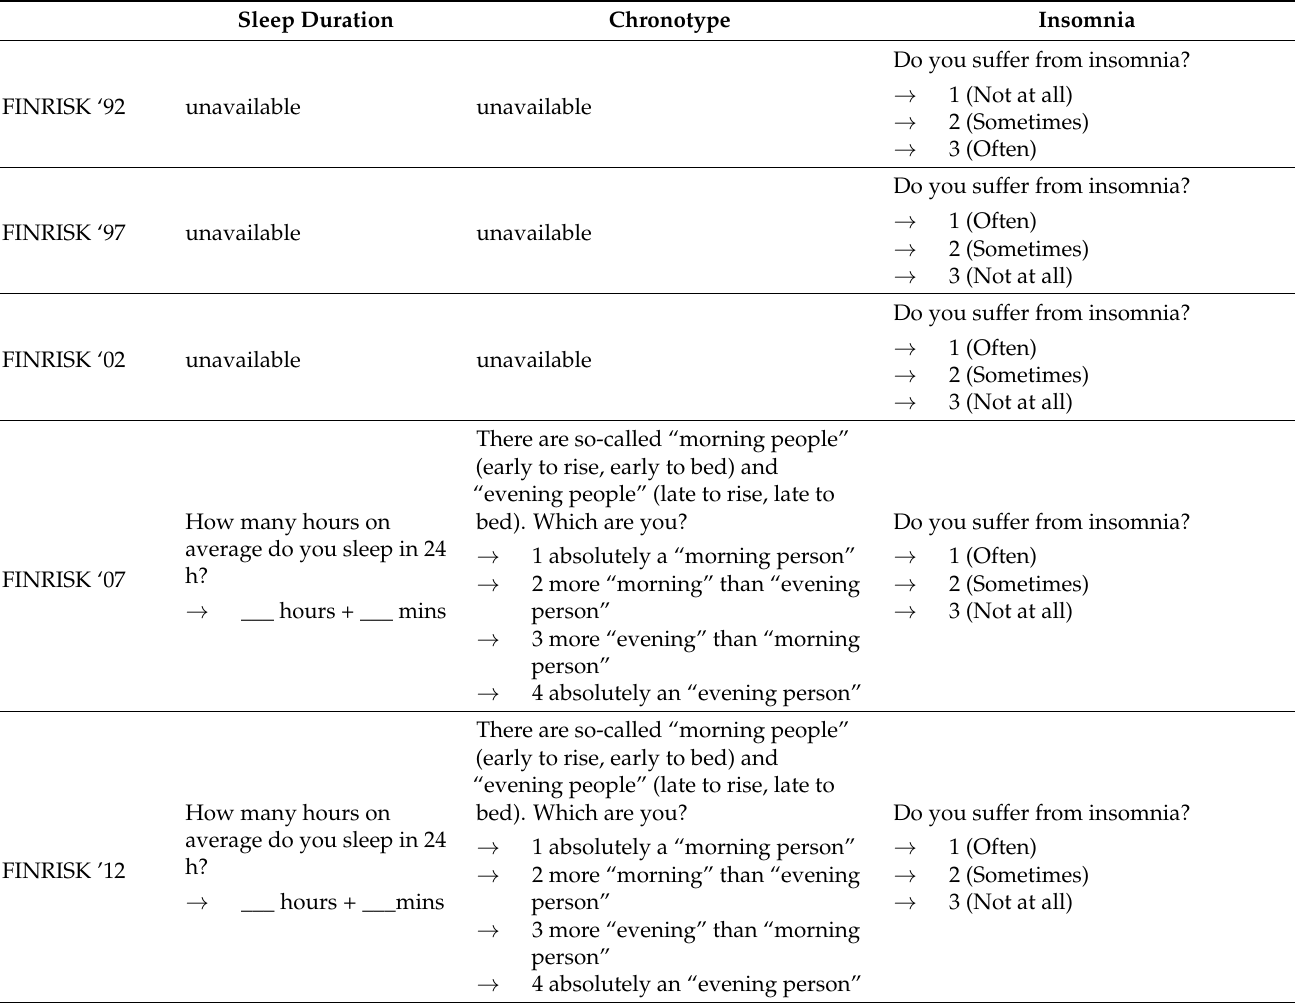
Table A1. Questions utilized to determine sleep duration, chronotype and insomnia of FINRISK and Health 2000/2011 cohorts. The full questionnaires can be found in the Finnish Institute for Health and Welfare webpage (both in English and in Finnish): https://thl.fi/en/web/thlfi-en/research-and- development/research-and-projects/the-national-finrisk-study/questionnaires, accessed on 20